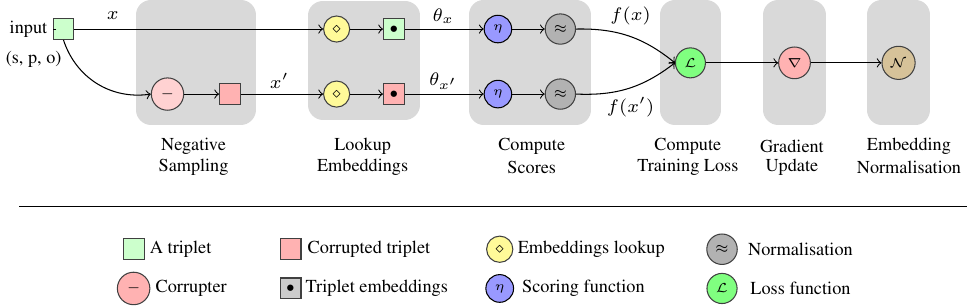
Figure 1. An illustration of the process of training a knowledge graph embedding model over an example triple x = ( s , p , o ) —the original triple—and x (cid:48) refers to a corrupted (negative) version of